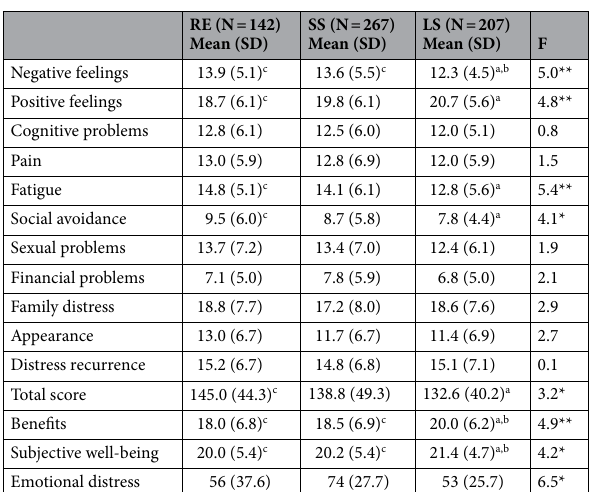
Table 2. ANOVA, post-hoc tests and Chi 2 for total sample by hormone therapy and survival phase phase. RE, re-entry subgroup; SS, short survival subgroup; LS, long survivor subgroup. * = p ≤ 0.05, ** = p ≤ 0.01, *** = p ≤ 0.001. a Significant differences with re-entry phase, b significant differences with short survival phase, c significant differences with long survival phase. The family distress subscale has been weighted in order to equalize the rank with the rest of the subscales.